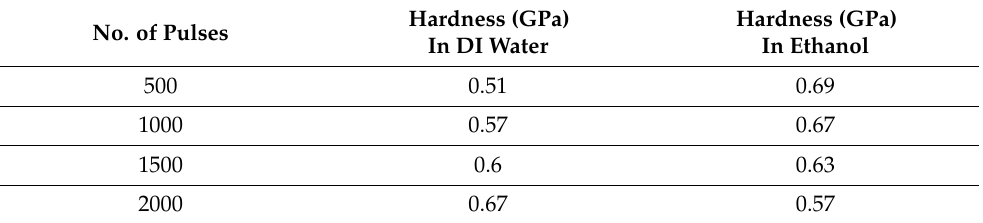
Table 4. The variation is hardness values of laser ablated Cd exposed to 500, 1000, 1500, and 2000 laser pulses at a constant fluence of 3.6 Jcm − 2 in DI water and